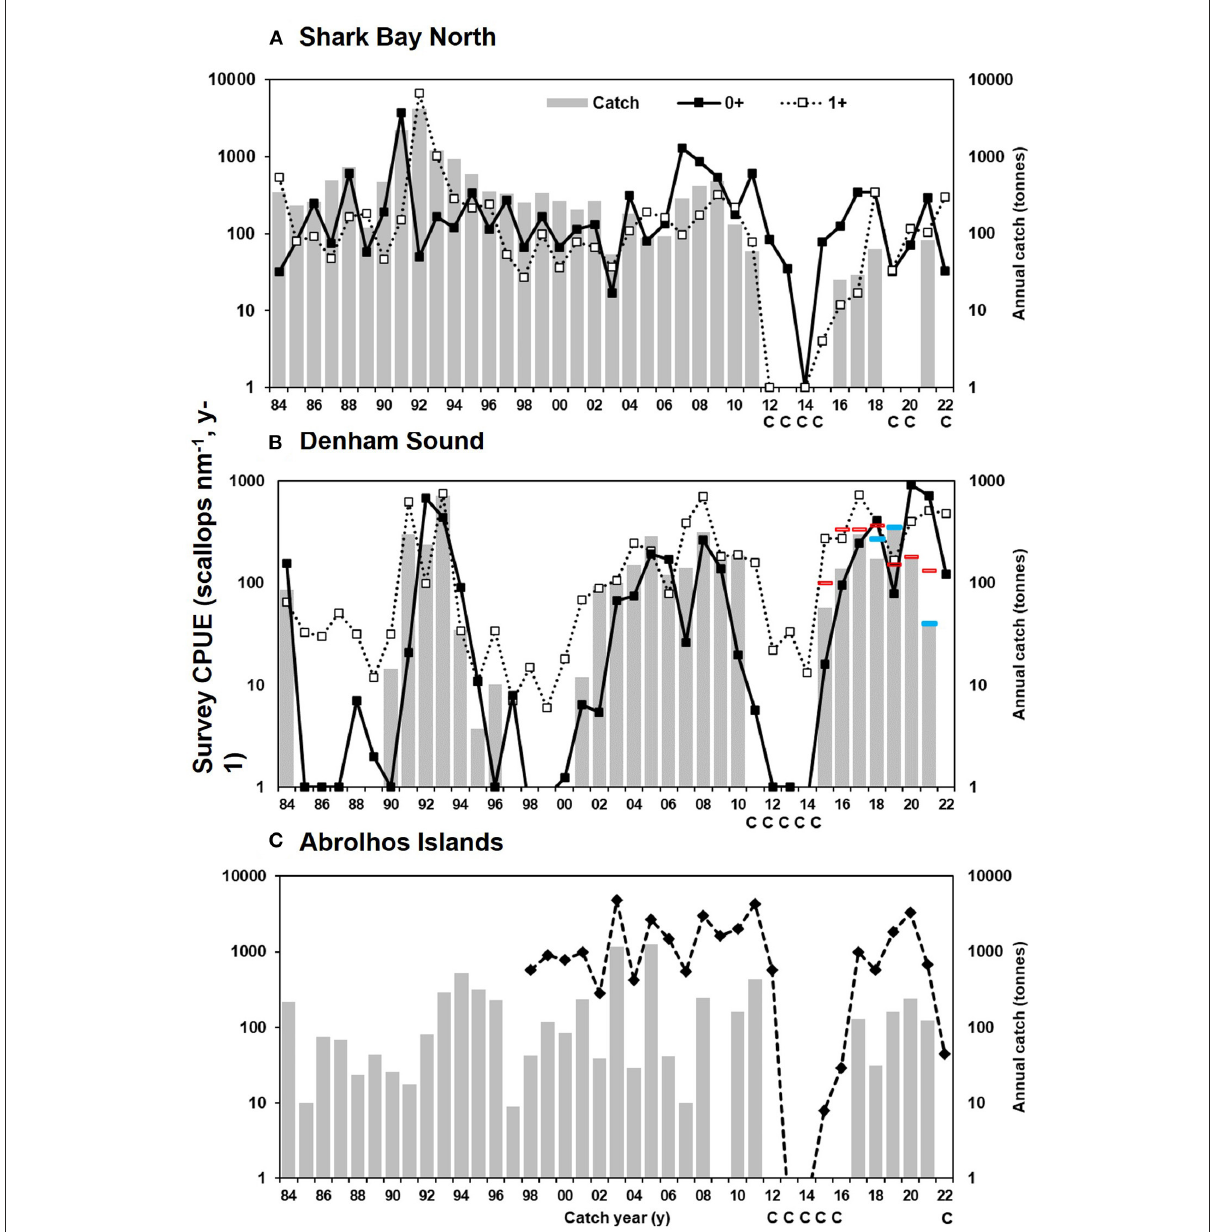
FIGURE5 Catch time series and 0 + and 1 + survey index (on logarithmic scale) for (A) Shark Bay North (B) Denham Sound (Red lines indicate the TACC set for the season − 1 May to 30 April; Blue lines indicate amended TACC if deemed appropriate); and (C) Abrolhos Islands with the survey index. The survey index is shown in the year following the survey to coincide with the catch year e.g., 1997 survey shown at 1998 catch year. C indicates fishery closure due to MHW or survey abundance below limit reference level.